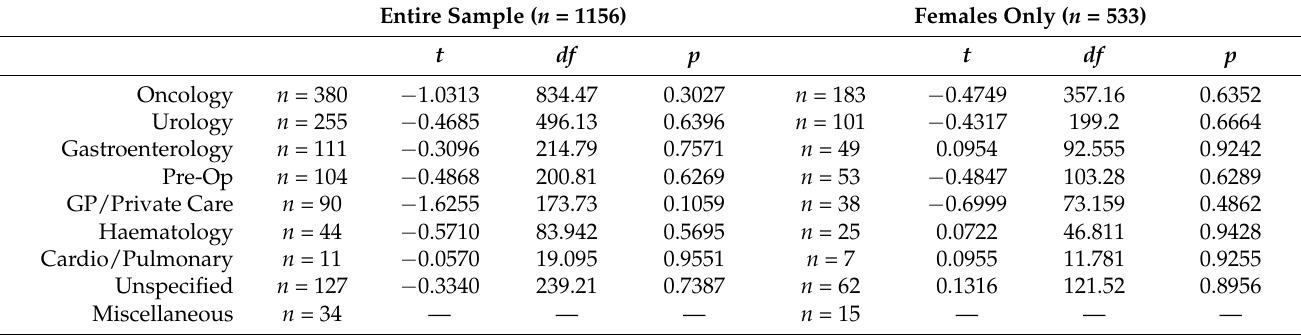
Table 2. T-test analyses comparing estimated mean age versus actual age by ordering